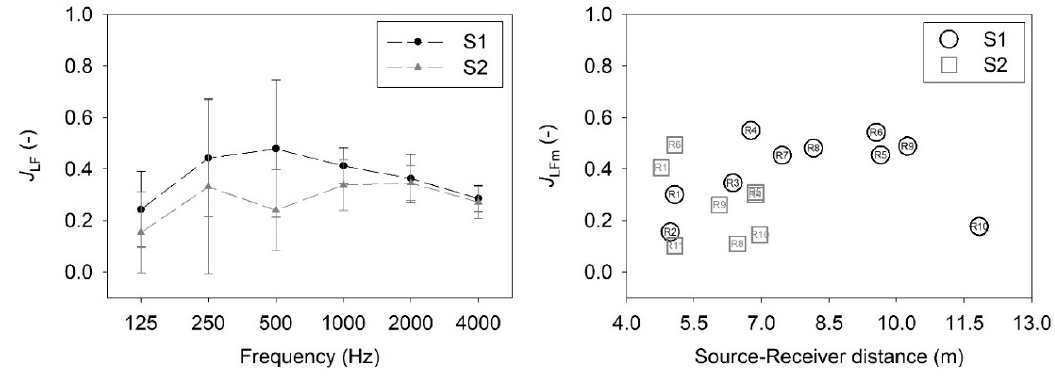
Figure 9. Spatially averaged values of the acoustic parameters as a function of frequency (left column), and mid values as a function of source-receiver distance (right column).